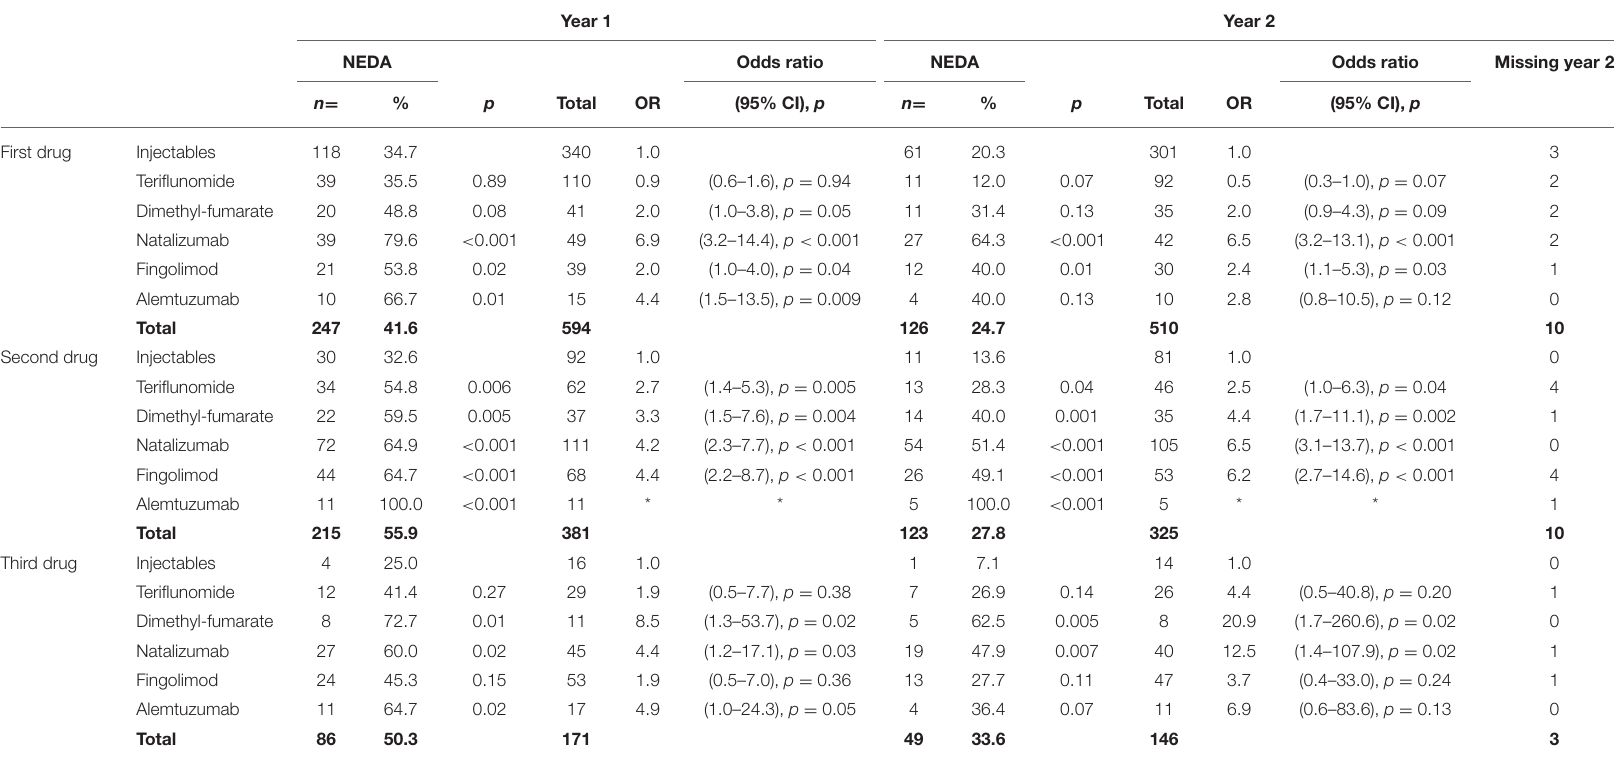
TABLE 7 | NEDA and odds ratio of reaching NEDA on individual drugs at year 1 and